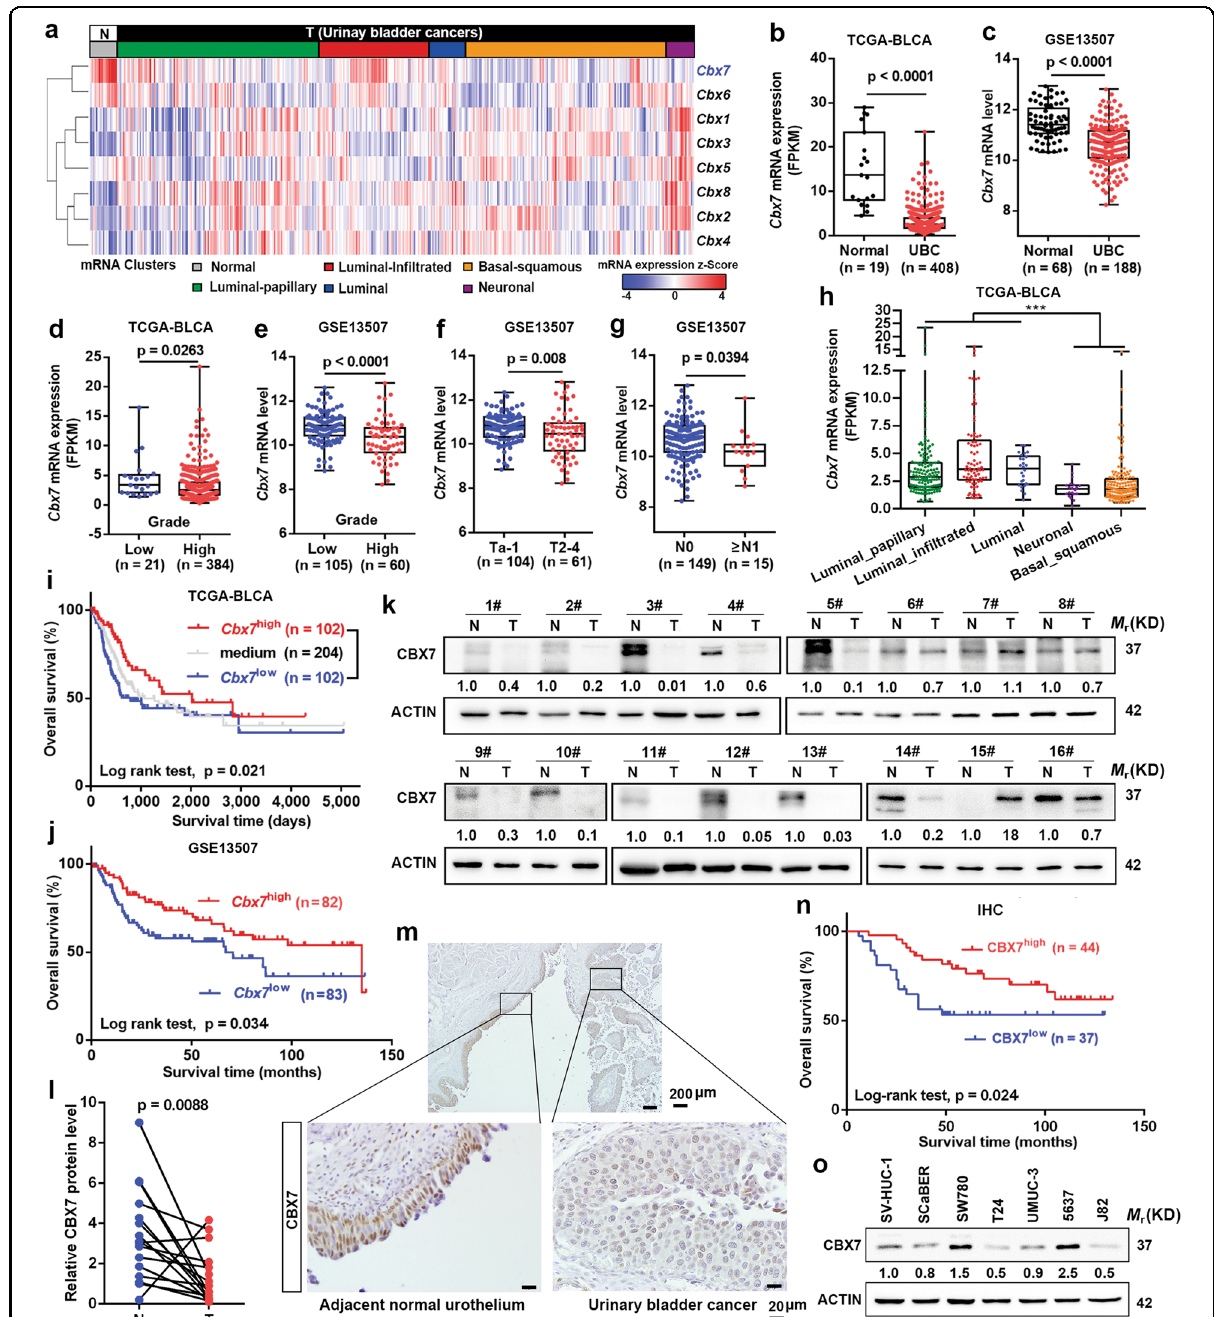
Fig. 1 The frequent downregulation of CBX7 correlates with poor prognosis in UBC patients. a Hierarchical clustering illustrates the expression of CBX genes in TCGA-BLCA between UBC tissues and the adjacent normal tissues. b , c CBX7 mRNA expression between UBC tissues and the adjacent normal tissues in TCGA-BLCA and GSE13507. d – g The association of CBX7 mRNA expression with clinicopathologic features in TCGA-BLCA and GSE13507. h CBX7 mRNA expression in fi ve UBC subtypes. i , j Kaplan – Meier plot of overall survival of UBC patients in TCGA-BLCA and GSE13507. k , l CBX7 protein levels in 16 paired UBC tissues (T) and their adjacent noncancerous tissues (N) were detected by western blotting. m IHC staining of CBX7 expression in a section containing UBC tissues and its tumor-adjacent noncancerous tissues. Scale bar, 200 μ m (upper panel); 20 μ m (lower panel). n Kaplan – Meier survival plot for CBX7 was constructed according to the IHC staining score. o Endogenous expression of CBX7 in a nonmalignant normal urothelial cell line and multiple human UBC cell lines by western blotting. Data are presented as means ± SD. *** p <